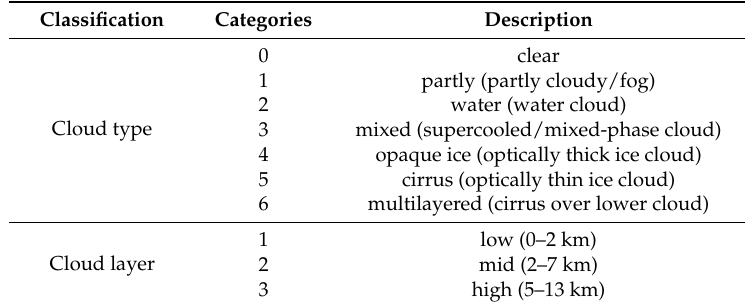
Table 1. Cloud categories for National Oceanic Atmospheric Administration (NOAA) cloud-types (same categories used in Reference [23]) and cloud-layer classifications from Geostationary Operational Environmental Satellite (GOES) surface and insolation products.